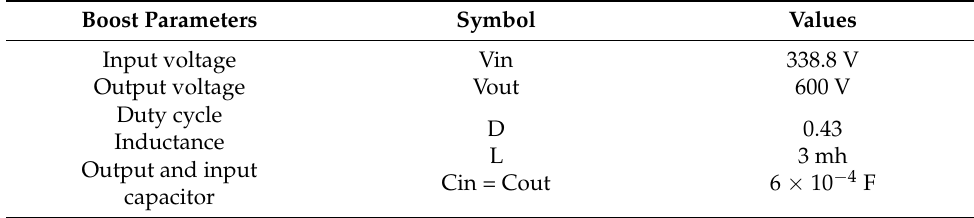
Table A2. Parameters of the boost